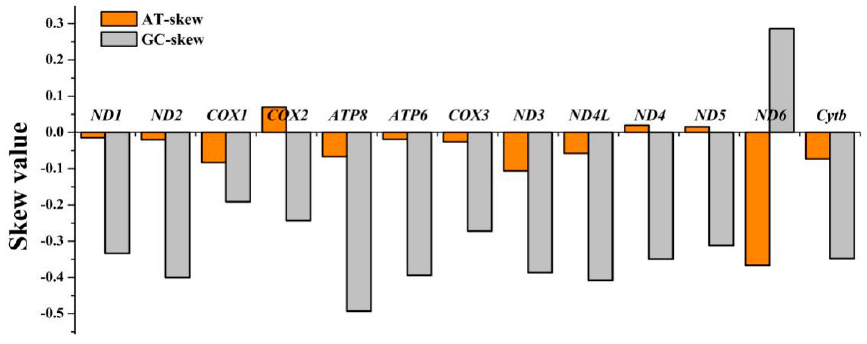
Figure 2. The AT skew and GC skew in the PCGs of the C. crocodilus mitogenome.